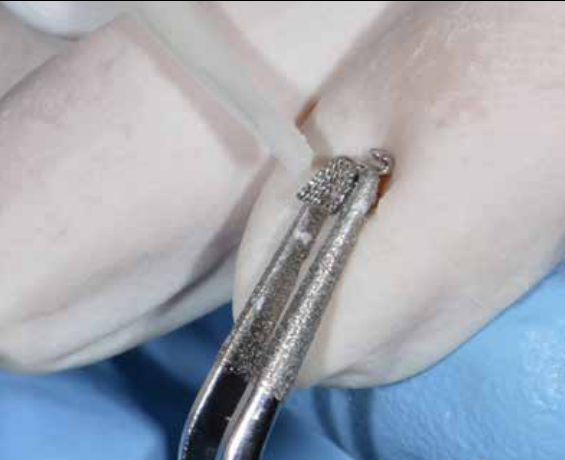
Figure 3. Extrude a small amount of RMGIC adhesive to the mesh base of the bracket.